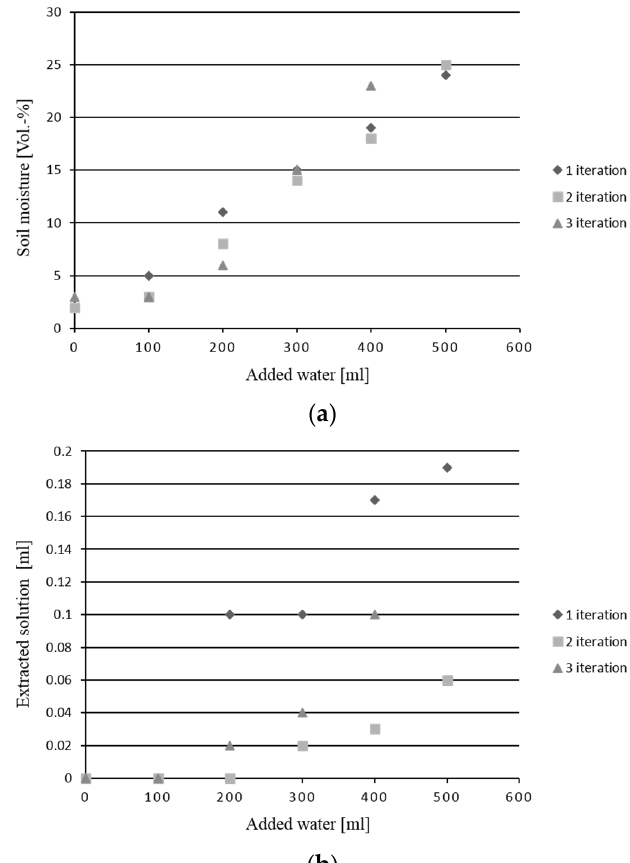
Figure 9. Evaluation of measurement variability: ( a ) soil moisture with added water; and ( b ) extracted